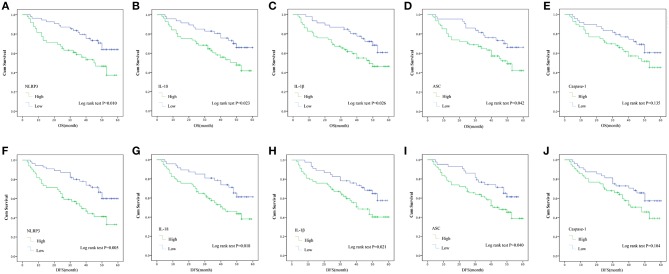
Kaplan–Meier with log rank test analyses of the influence of the expression of the NLRP3 inflammasome on the 5-year OS and DFS for 104 LSCC patients. OS: (A) NLRP3; (B) IL-18; (C) IL-1β; (D) ASC; (E), Caspase-1. DFS: (F) NLRP3; (G) IL-18; (H) IL-1β; (I) ASC; (J) Caspase-1.